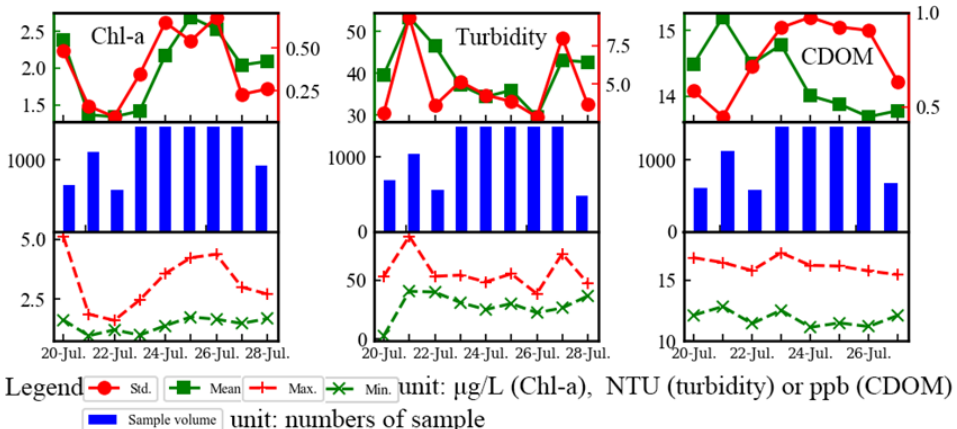
Figure 12. Statistics of Chl-a, turbidity, and CDOM in the deployment site (Figure 7) from 20 July 2013, to 28 July 2013.